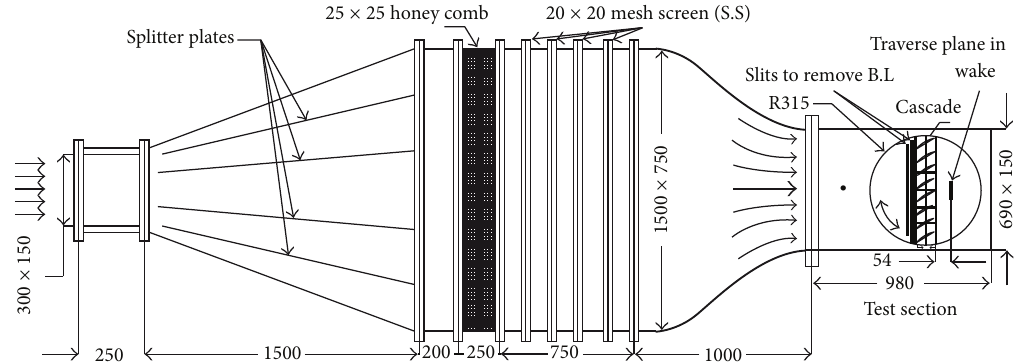
Figure 2: Schematic diagram of open circuit cascade wind tunnel.